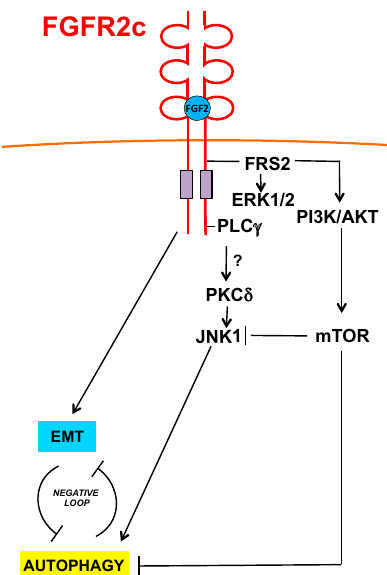
Figure 7. Schematic drawing of the proposed role of FGFR2c and its signaling in the regulation of autophagy and EMT interplay. FGFR2c inhibits autophagy via AKT / MTOR pathway, which also negatively interferes with JNK1 signaling.